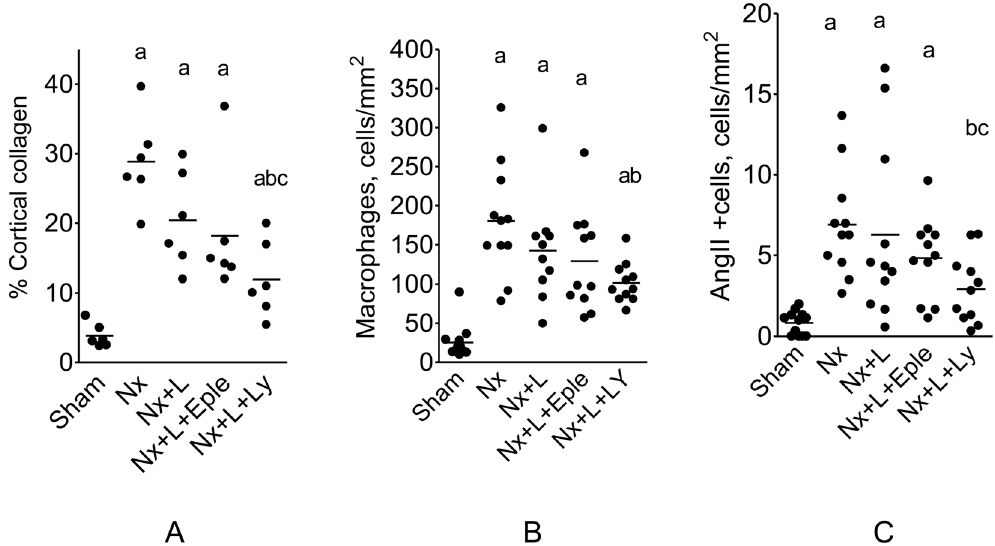
Figure 7. Percent cortical area occupied by collagen I ( A ) and the density of interstitial infiltration by macrophages ( B ) and AngII + cells ( C ) 150 days after renal ablation in Protocol 2 (late treatment). a p < 0.05 vs. Sham, b p < 0.05 vs. Nx, c p < 0.05 vs. Nx +